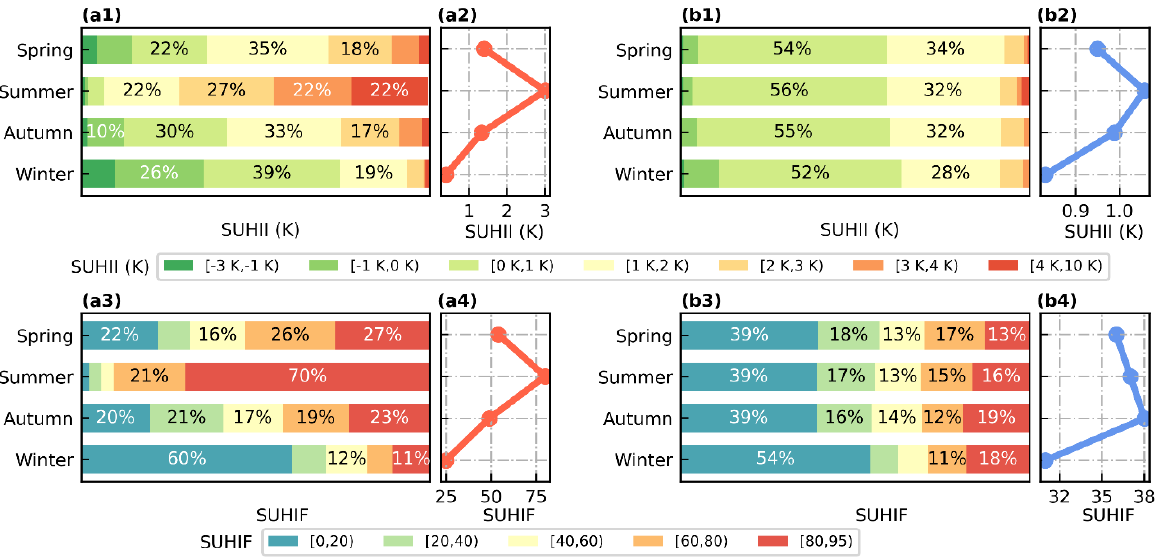
Figure 6. Seasonal variations of SUHII and SUHIF at daytime ( a ) and nighttime ( b ). The discrete distribution as horizontal bar charts in the first row shows seasonal variations of SUHII ( a1 , b1 ) and the second row charts show that of SUHIF ( a3 , b3 ). Percentage over 10% is labelled in the graph. The line plots in the first row show the average of SUHII ( a2 , b2 ) and plots in the second row show that of SUHIF ( a4 , b4 ) among the different seasons.